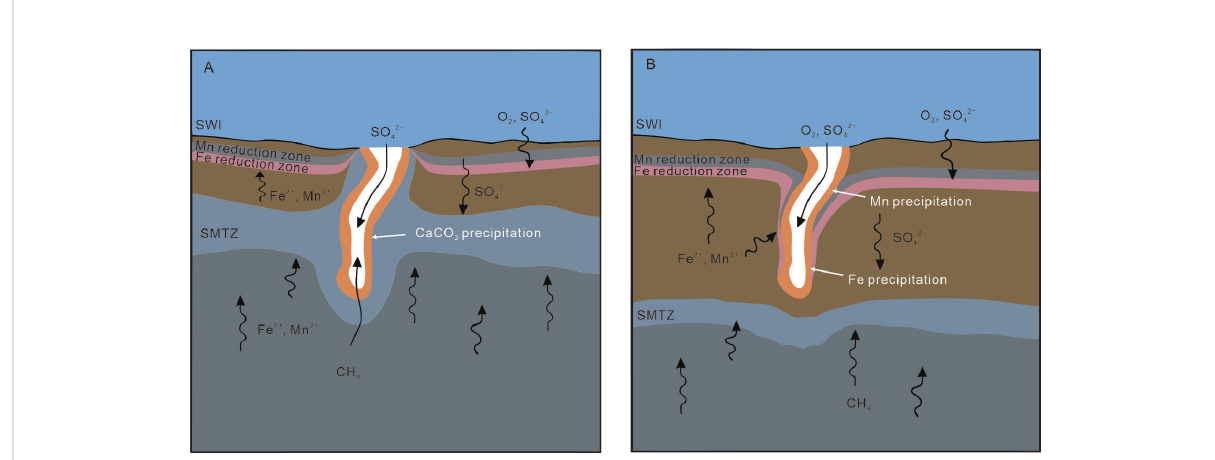
FIGURE 9 The proposed schematic diagram for the precipitation of the studied tubular carbonates (modi fi ed after Zwicker et al., 2015). (A) Tubular carbonate precipitates during relatively high seep fl ux. (B) Sulfate and methane transition zone (SMTZ) and Fe/Mn reduction zone migrated downward when fl ux decreased, facilitating Fe/Mn (oxyhydr)oxides to precipitate in the